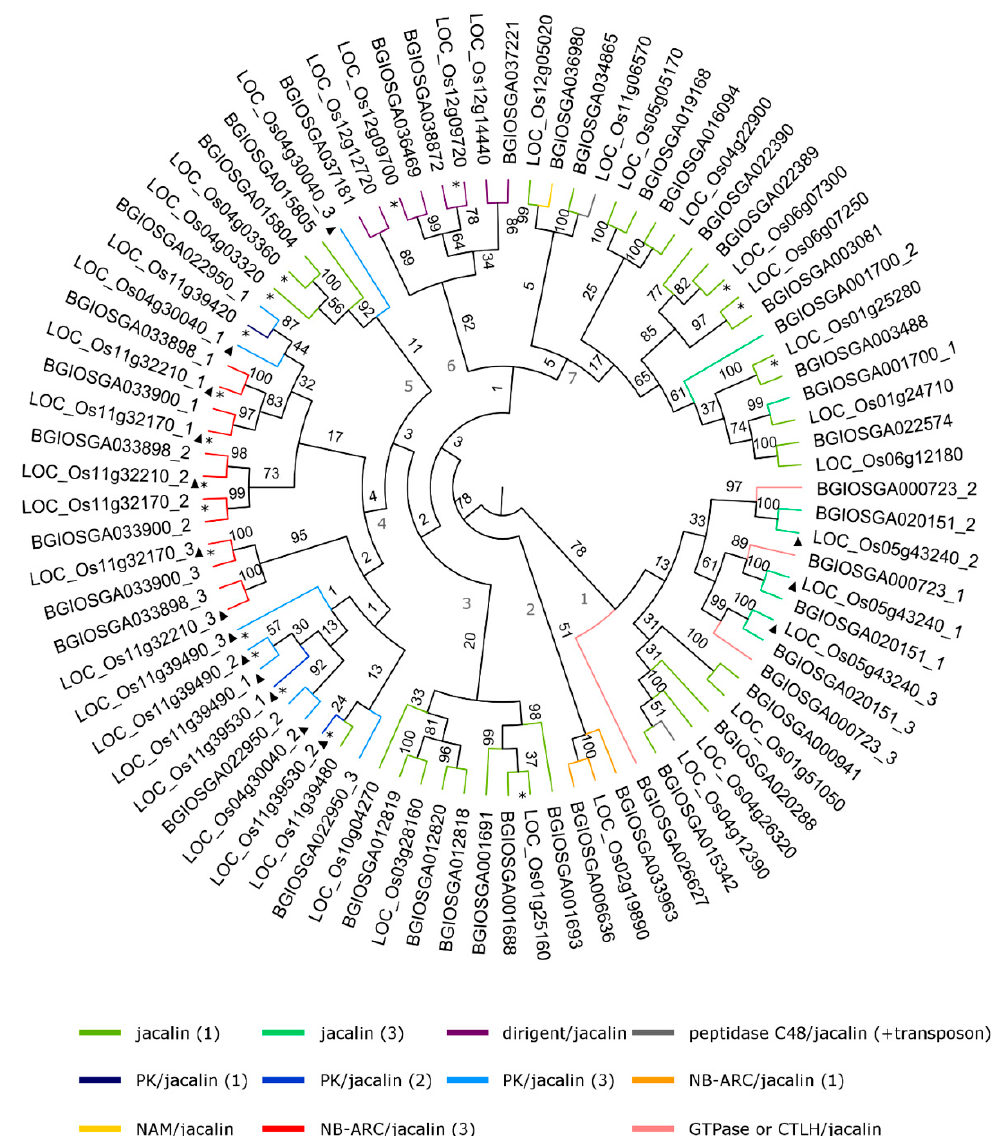
Figure 5. Phylogenetic tree of the Jacalin lectin family. Asterisks refer to tandem duplication events whereas triangles represent a single lectin domain in a multiple domain structure. The black numbers indicate the bootstrap values while the grey ones indicate the number of the clades. The numbers separated by an underscore from the ID of the genes are referring to the number of the lectin domain in multiple domain sequences.